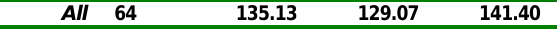
Table 2. Descriptive statistics of the total tea polyphenols